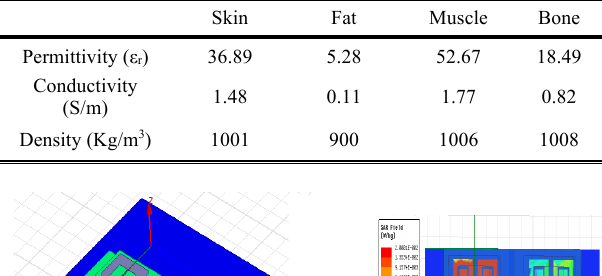
TABLE IV . Material characteristics of human biological